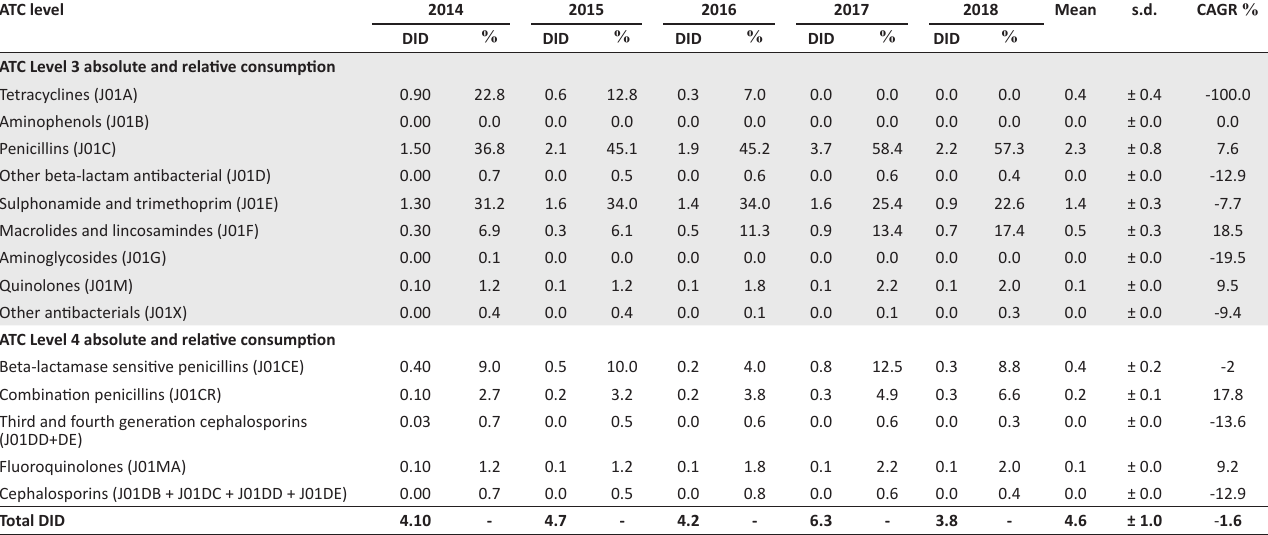
TABLE 2: Absolute and relative antibiotic consumption at Anatomical Therapeutic Chemical levels 3 and 4, mean and compound annual growth rate. ATC